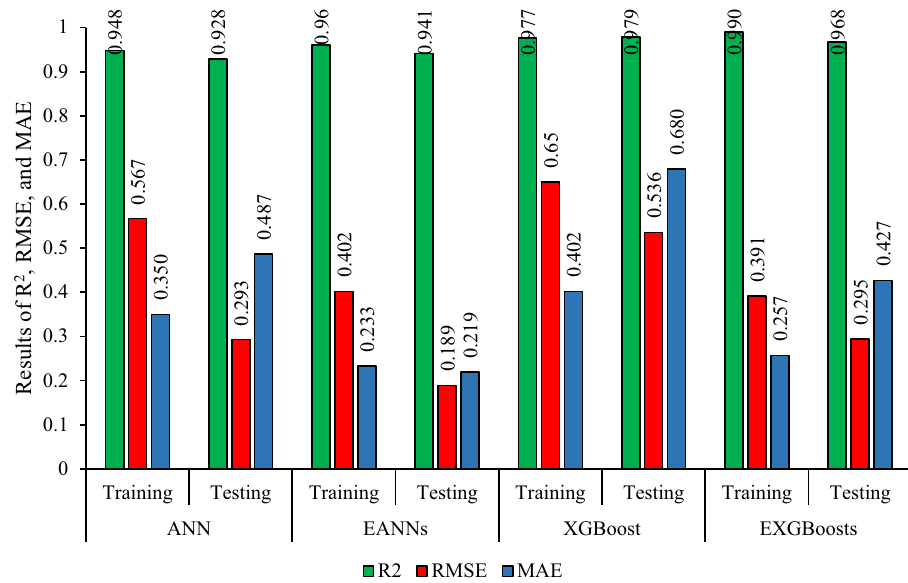
Figure 10. The value of R 2 , RMSE, and MAE for selecting the best model in the predicting PPV